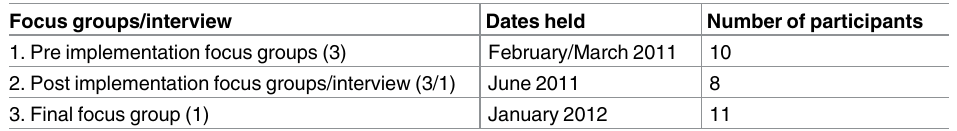
Table 3. Summary of focus